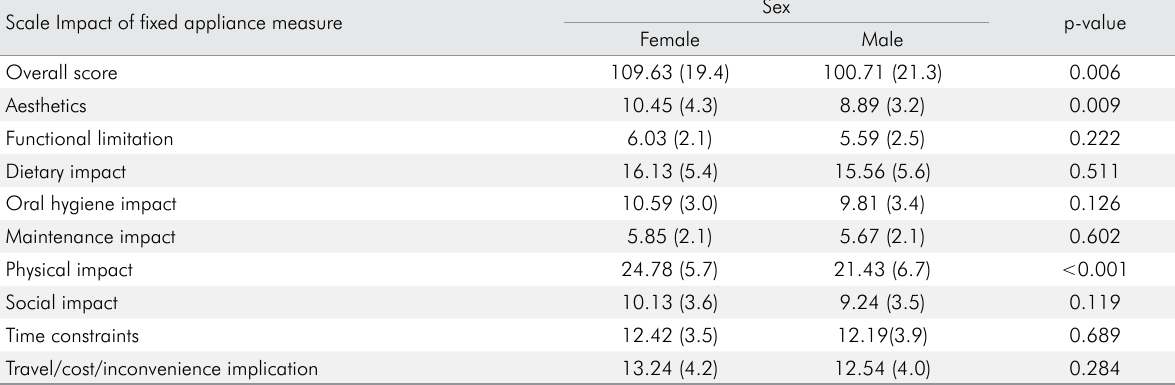
Table 4. Discriminant validity: Comparison of the impact of fixed appliance measure with sex. Scale Impact of fixed appliance